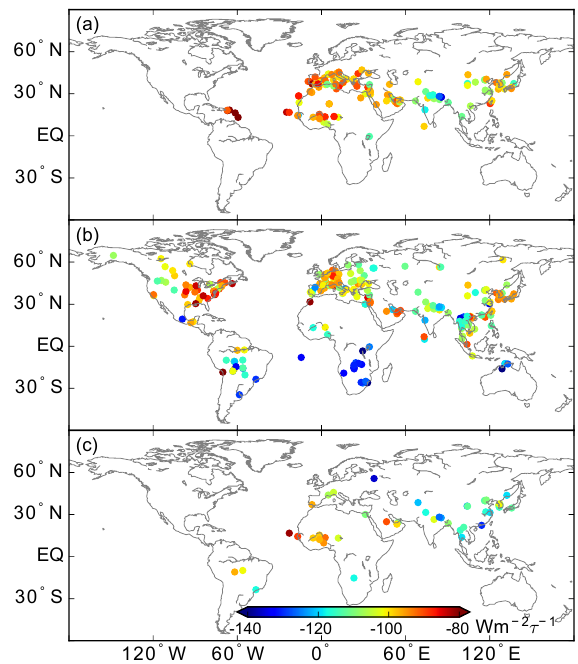
Figure 5. Aerosol radiative efficiency at BOA: (a) dust aerosols, (b) anthropogenic aerosols, and (c) mixed-type aerosols.